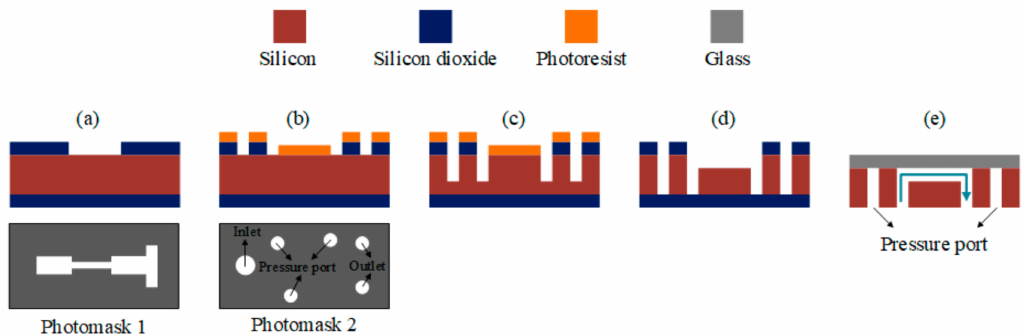
Figure 2. Fabrication process flow. ( a ) The etched silicon dioxide layer after the first photolithography step; ( b ) the etched silicon dioxide layer after the second photolithography step before removing the photoresist; ( c ) the first deep reactive ion etching of the wafer; ( d ) the second deep reactive ion etching of the microfluidic channel after removing the photoresist layer; ( e ) microfluidic device anodically bonded to the glass (the final